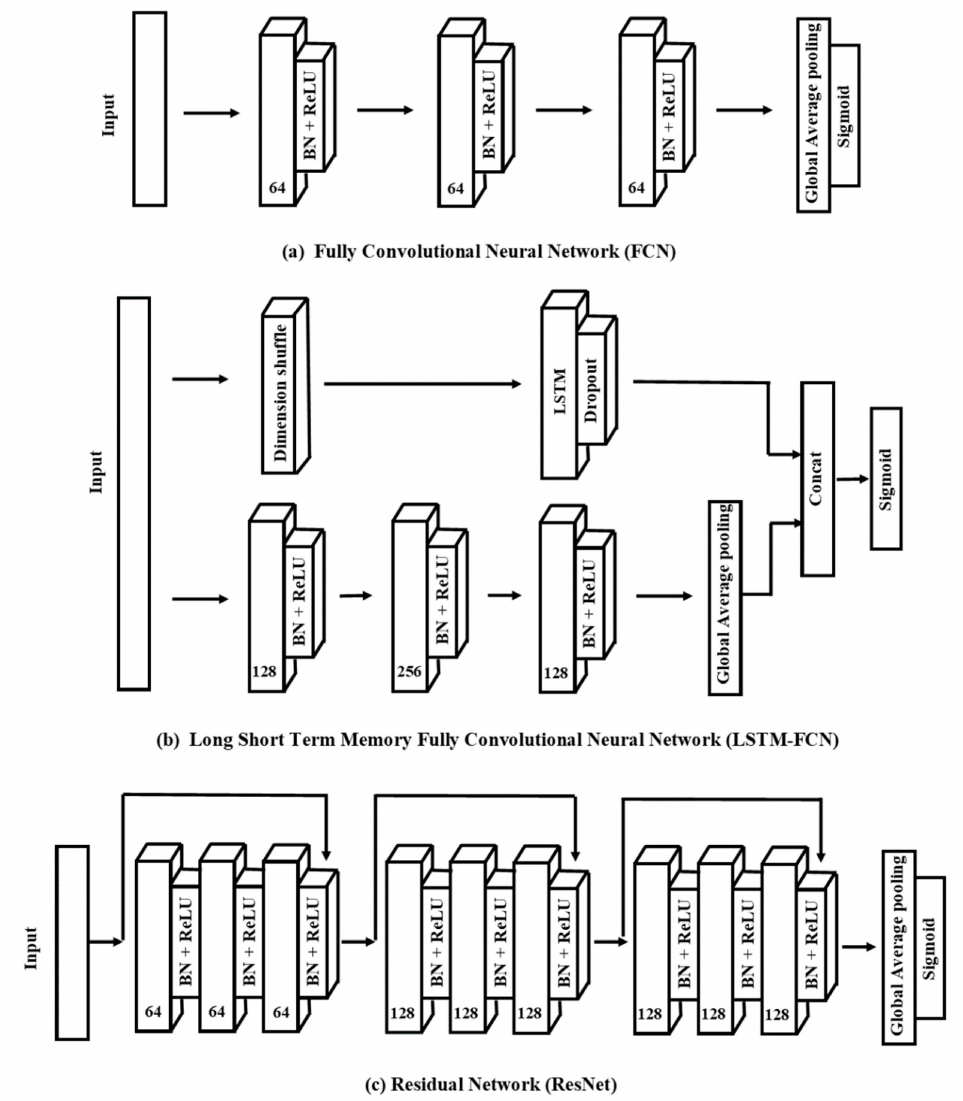
Figure 2. The network structure of FCN ( a ), LSTM-FCN ( b ), and ResNet ( c ); feature extractor: block with a convolutional layer plus a batch normalization ( BN ) layer and a ReLU activation function; output layer: global average pooling with a sigmoid activation